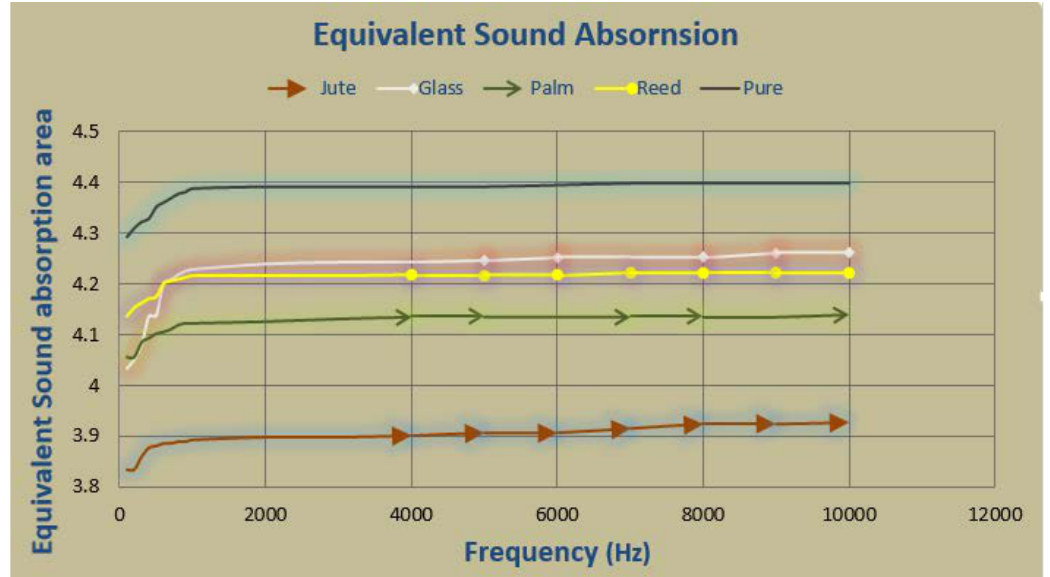
Fig.10: Equivalent sound absorption -frequency for natural fibers composites with glass fibers composite.